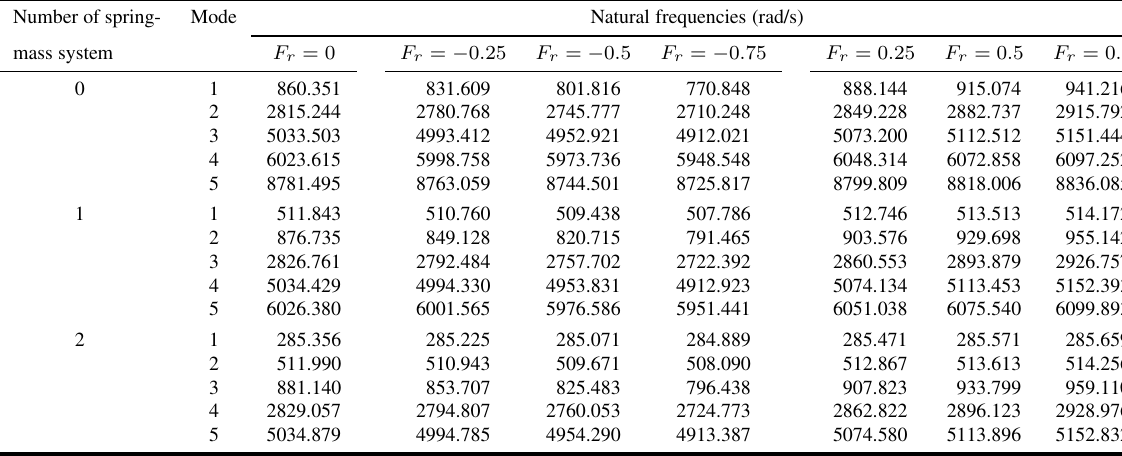
Table 4 The lowest five natural frequencies of the two-span beam used in example 4. ( ξ 3 = 0 . 3